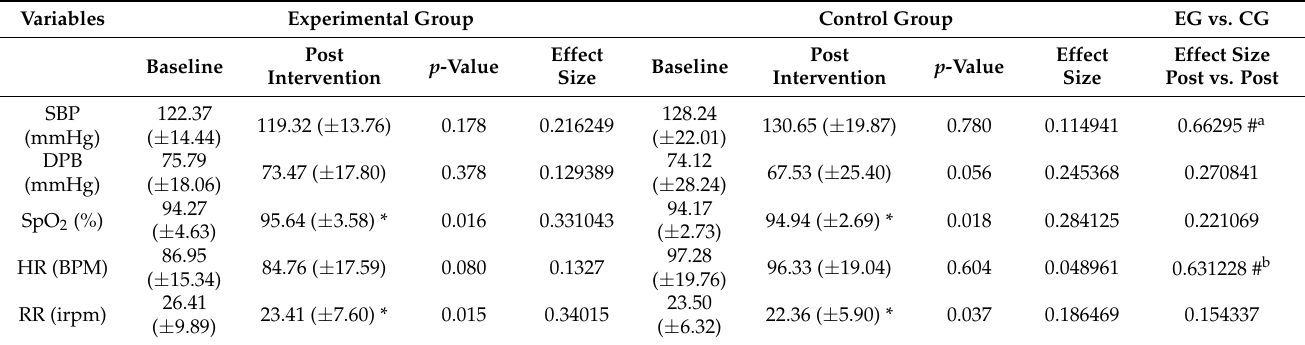
Table 3. Secondary